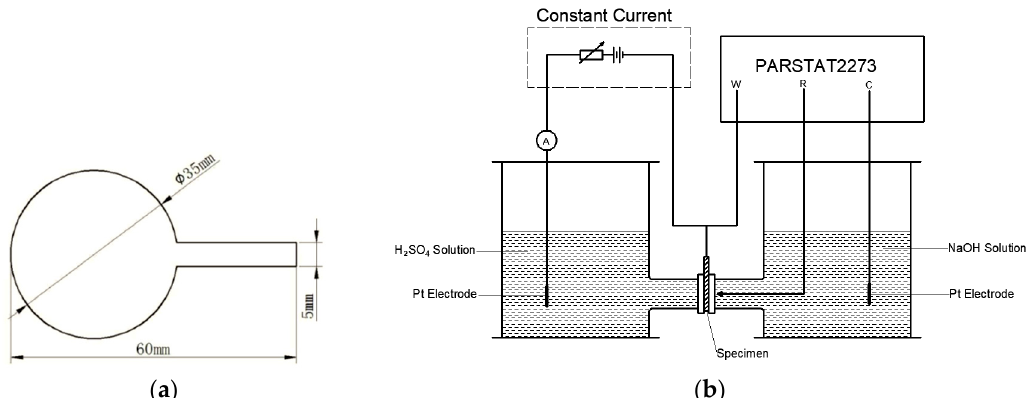
Figure 3. ( a ) The X80 specimen. ( b ) The equipment designed for this study, which consisted of a constant current, the PARSTAT2273, and double electrolysis cells.